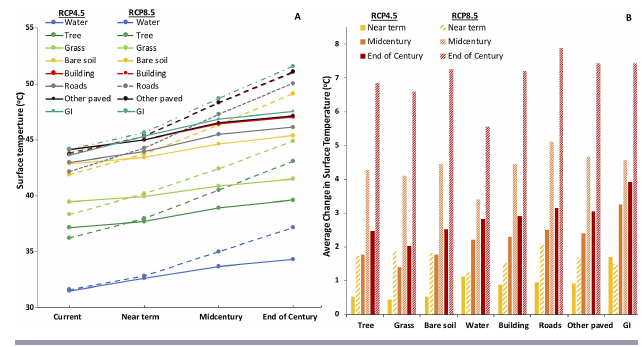
Fig. 4 . (A) Average surface temperature by time period. (B) Average change in surface temperature by landcover, time period, and climate change scenario.